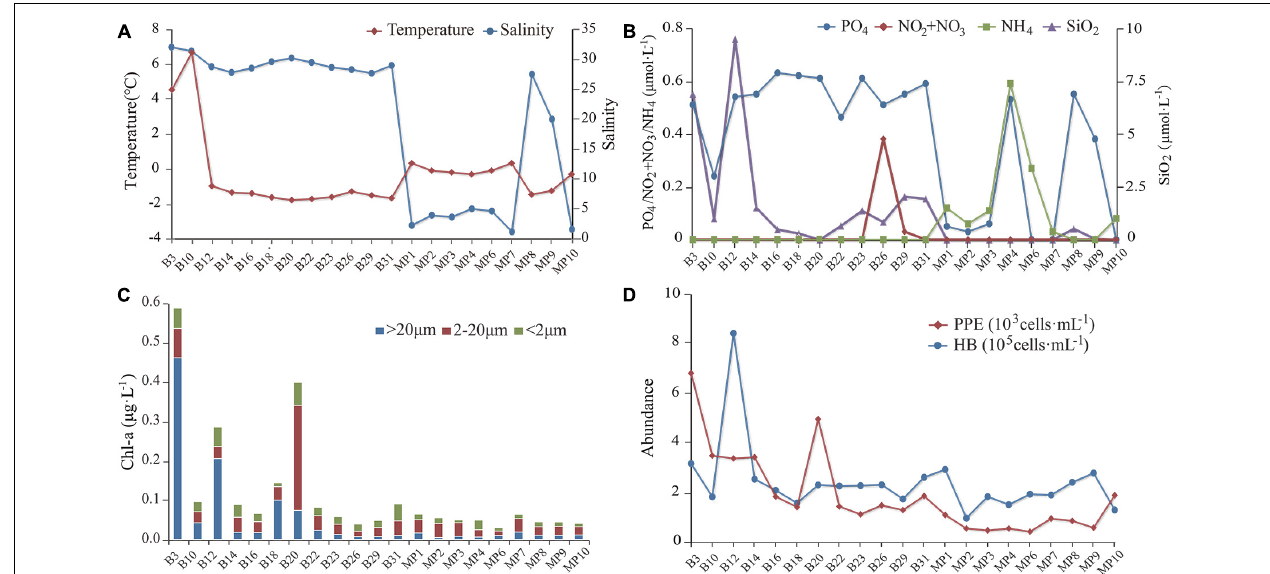
FIGURE 2 | The environmental parameters measured at the sampling sites. (A) Water temperature and salinity. (B) Concentrations of NO 2 /NO 3 , PO 4 , NH 4 , and SiO 2 . (C) Size-fractionated chlorophyll a concentration. (D) Abundances of heterotrophic bacteria (HB) and pico-sized pigmented eukaryotes